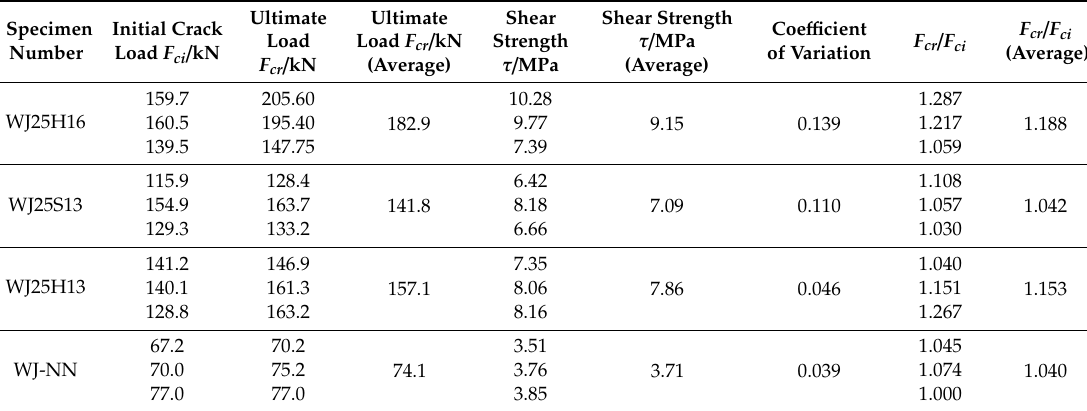
Table 6. Direct shear test results of the